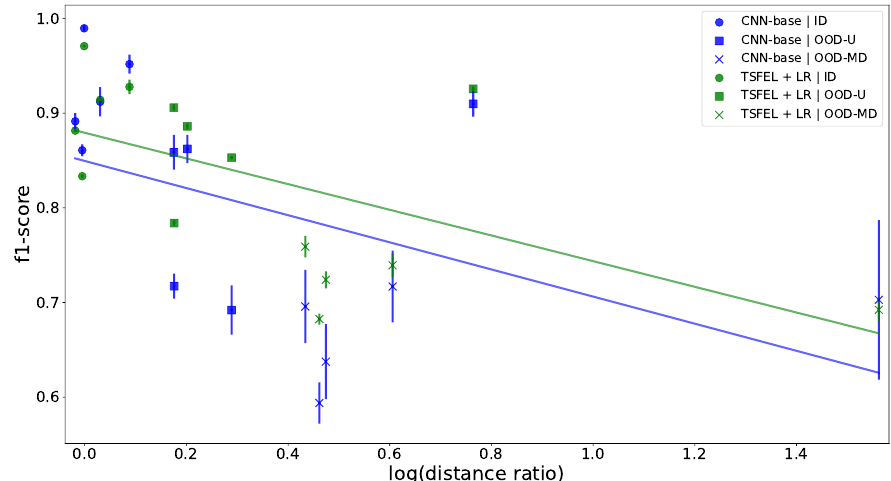
Figure A2. TSFEL + LR vs. CNN-base. Distance ratios are based on TSFEL features.